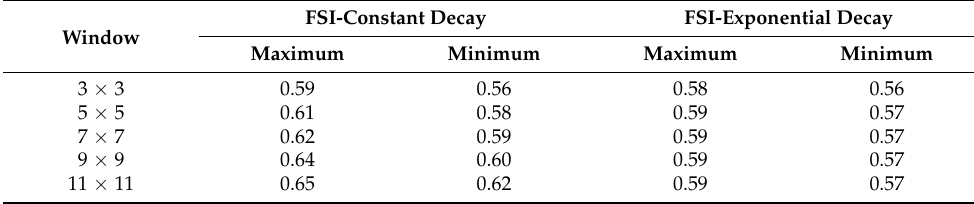
Table 5. Statistical validation by Hagen ’ s method: 2006 – 2018.